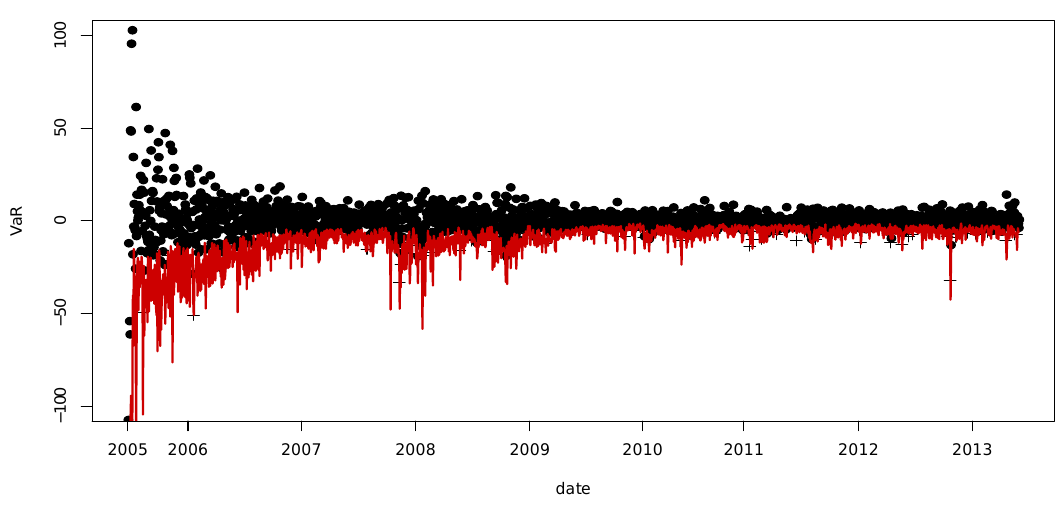
Figure 1: Exceedances plot for VaR ( α ) with α = 0.05 on the IBM-Google portfolio for the Lévy copula model. The dots represent the empirical portfolio value stated by the data, the “+” signs correspond to the